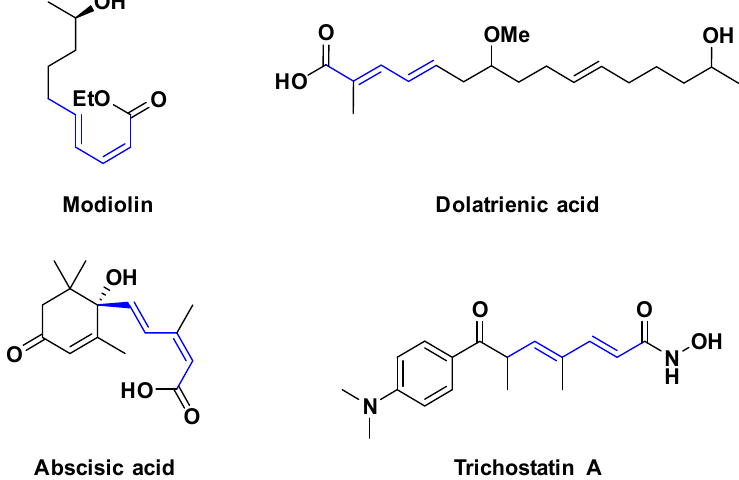
Figure 1. Examples of natural products containing a conjugated diene moiety.